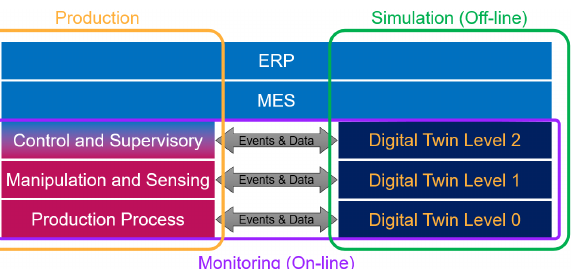
Figure 4. Multi-level concept and the DT operational modes. [Source: Own